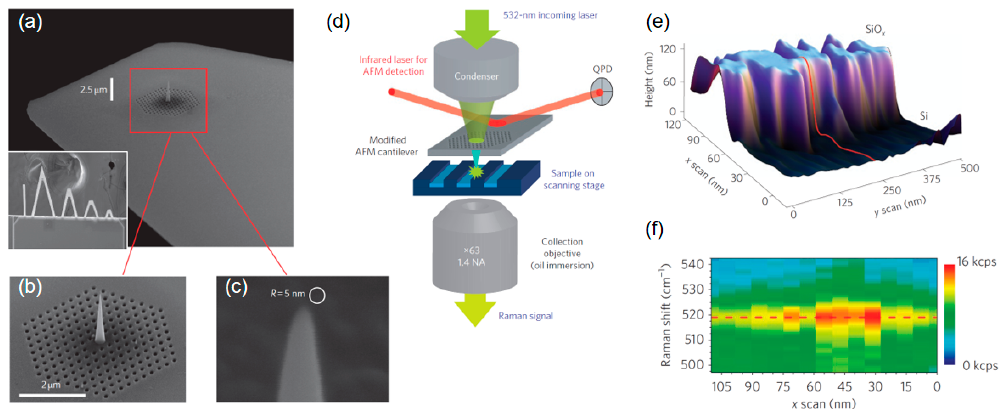
Figure 11. FEBID / focused ion beam (FIB) assisted, photonic / plasmonic tip-enhanced Raman scattering (TERS) nano-probe. ( a ) Overview of a 100 nm thick Si 3 N 4 AFM cantilever, equipped with the photonic and plasmonic element, based on FIB and FEBID, respectively. ( b ) shows a close up in which the FIB holes (160 nm diameter and 250 nm distance) are evident. The central element uses a Pt-based 3D-FEBID pillar as scaffold, further coated with pure Ag and milled down via FIB to apex radii of 5 nm and below ( c ). Such TERS nano-probes are then used in AFM-based configuration, as shown in ( d ), where the laser couples in from the backside via the photonic element, launching surface plasmons. After propagation along the cone structures, they induce a localized plasmon resonance at the tip apex in a nanometer- sized volume. ( e ) shows an AFM height image in 3D representation of a sub-micrometer Si nanocrystal/SiO x trench. The Raman intensity along the red line is shown in ( f ) in a spectrally resolved diagram, where the intensity variation reflects the crystallinity degree. As evident, the applied step size of 7 nm allows for sharp intensity edges, which confirms a sub-10 nm resolution in TERS operation.